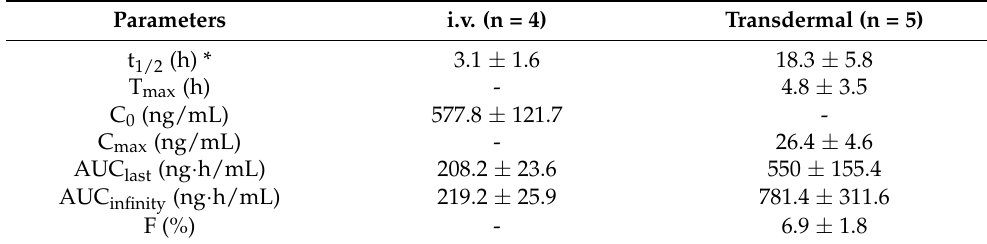
Table 3. Toxicokinetic parameters of BP-3 obtained after i.v. injection and transdermal administration at doses of 1 mg/kg and 40 mg/kg, respectively, in rats (mean ± S.D.).